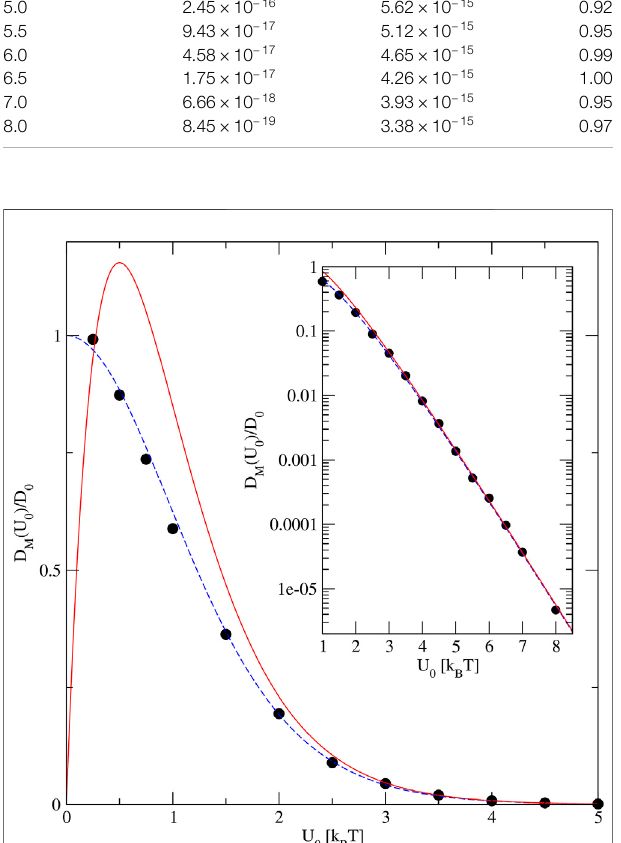
FIGURE 7 | (Color online): Long-time diffusion coef fi cient D M ( U 0 ) of a spherical tracer as a function of the maximum height barrier U 0 . The black solid circles, the blue dashed-line, and the red solid-line correspond to Brownian dynamics, the Lifson-Jackson prescription ( Eq. 15 ), and the Dalle-Ferrier formula ( Eq. 14 ), respectively. In all cases, L (cid:2) 1 . 0 × 10 − 6 m and D BD 0 (cid:2) D 0 (cid:2) 1 . 8 × 10 − 13 m 2 / s .